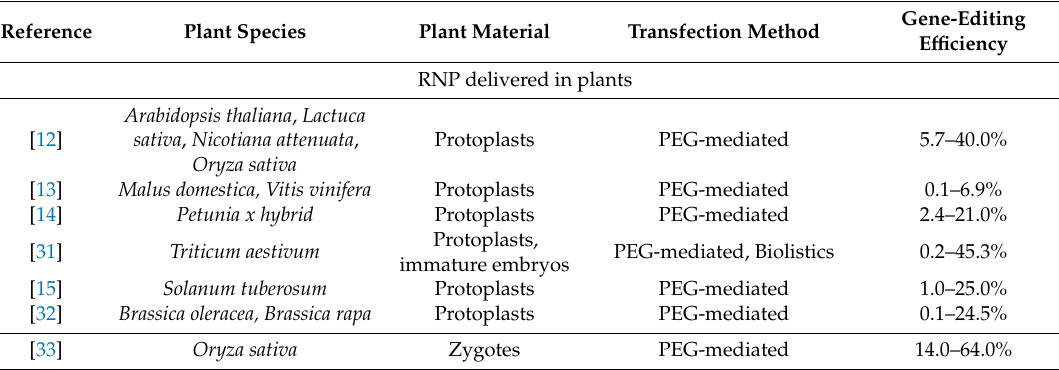
Table 3. Publications with DNA-free gene editing in plants using CRISPR-Cas9 RNPs and other delivery methods for